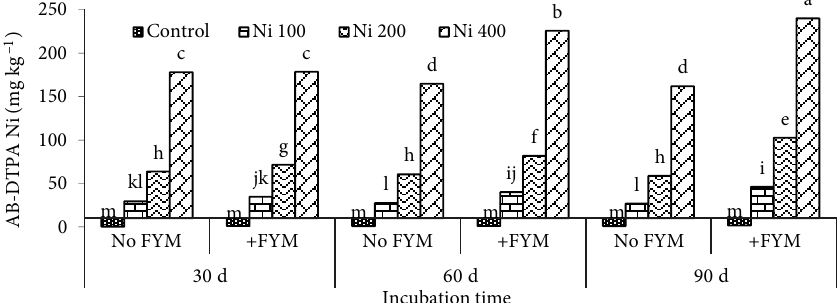
Fig. 2. Effect of incubation time on availability of Ni. FYM – farmyard manure; d – day. Lower case letters indicate the significance of treatments at P <